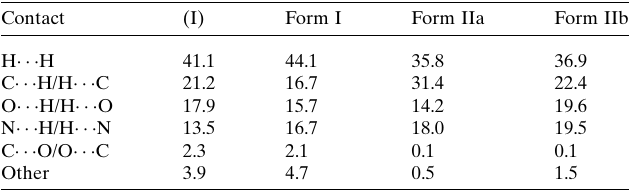
Table 4 A comparison of the distribution of contacts (%) to the calculated Hirshfeld surfaces for (I) and for Forms I and II (Jotani et al. , 2016).